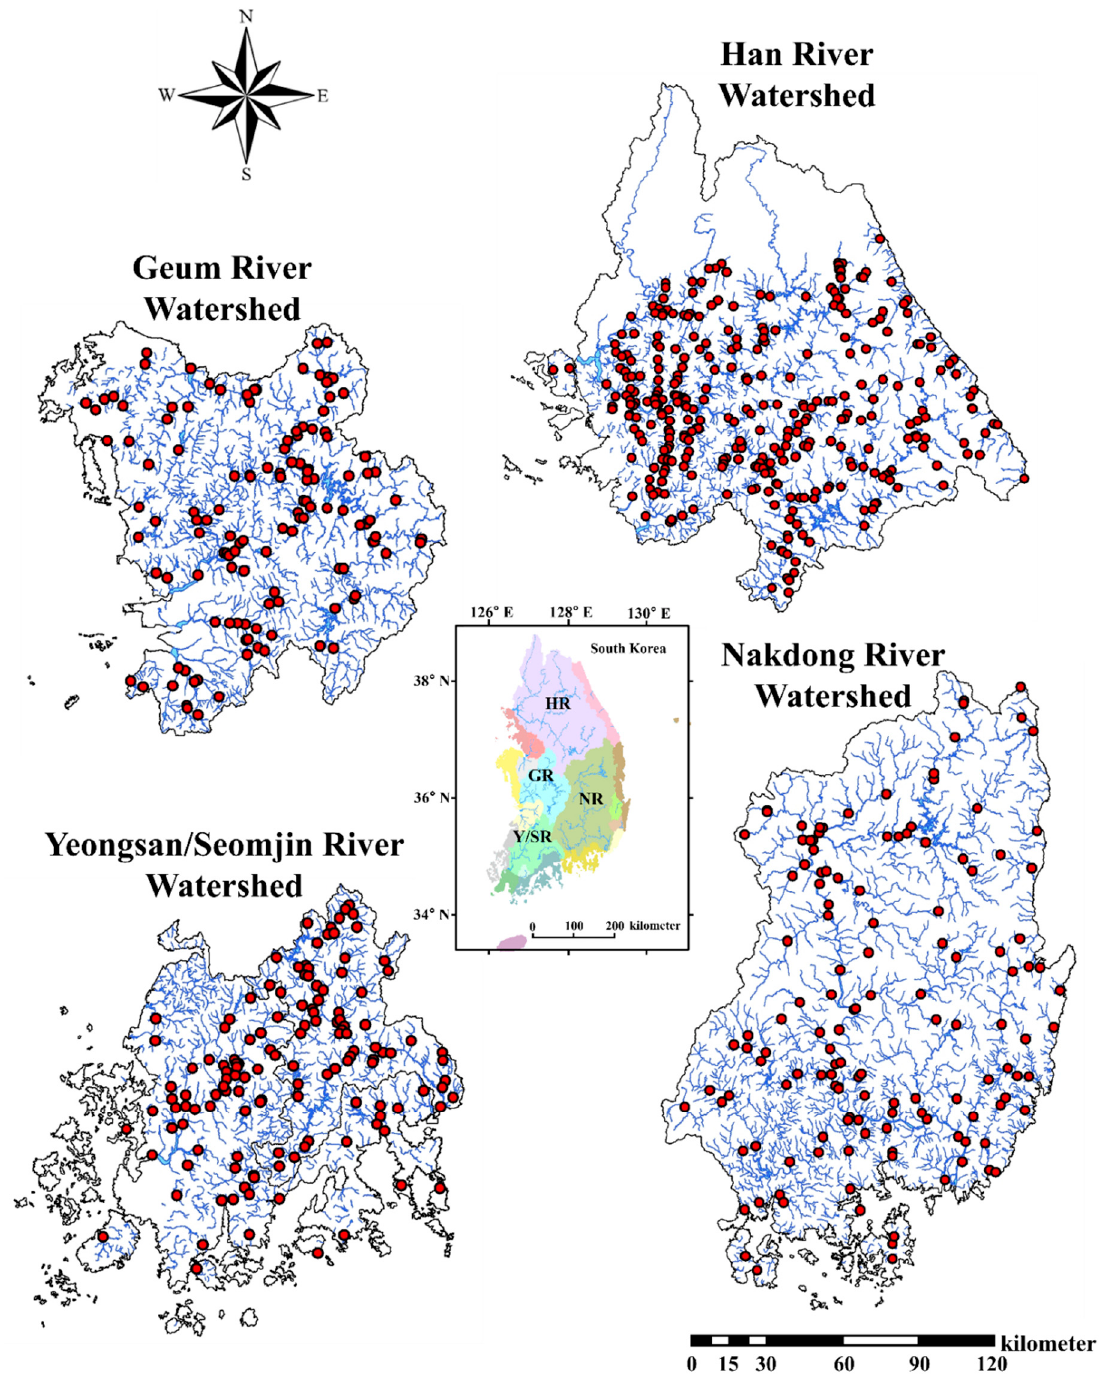
Figure 1. Study area map showing distinct watershed boundaries of each of the four major rivers included as well as the distribution of all the study sites sampled during this